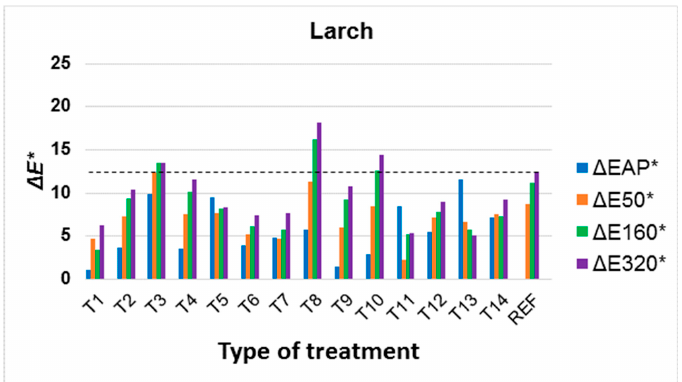
Figure 4. Colour changes in oak wood after application of surface treatment ( Δ EAP*) and after 50, 160 and 320 h ( Δ E50*, Δ E160*, Δ E320*) of accelerated ageing. (All evaluated total colour changes Δ E* in graph were compared to untreated wood surface; the dotted line in the graphs shows the comparison of Δ E* after 320 h of ageing between untreated samples (REF) and treated samples (T1–T14).) Materials 2018 , 11 , x FOR PEER REVIEW